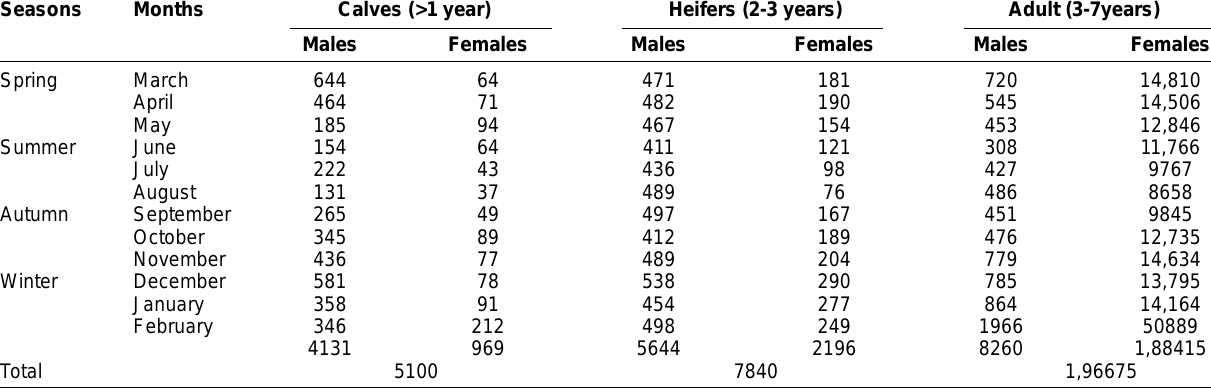
Table-1. Number of buffaloes slaughtered at Mirha Exports Private Ltd, Punjab Seasons